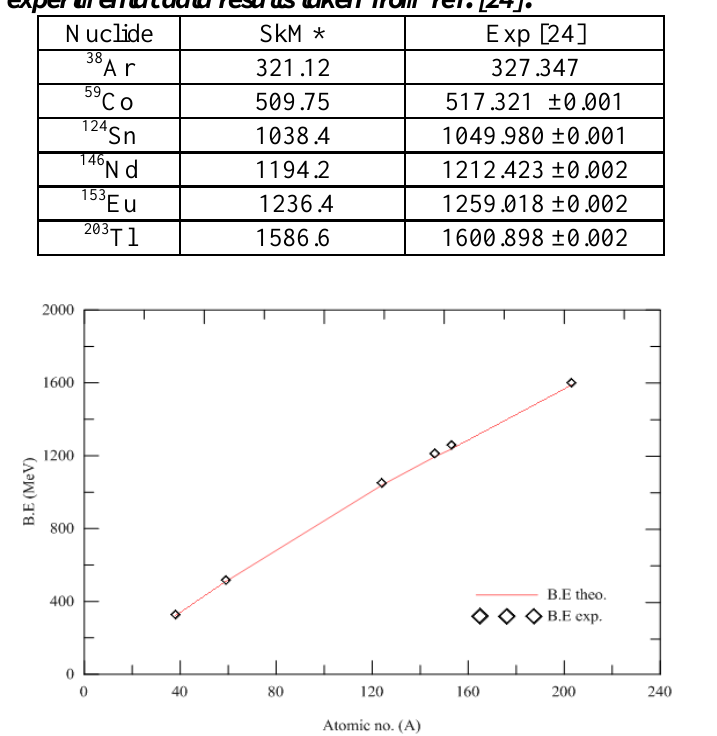
Table 4: The calculated binding energy using SkM* Skyrme parameterization in MeV and compared with experimental data results taken from ref. [24].